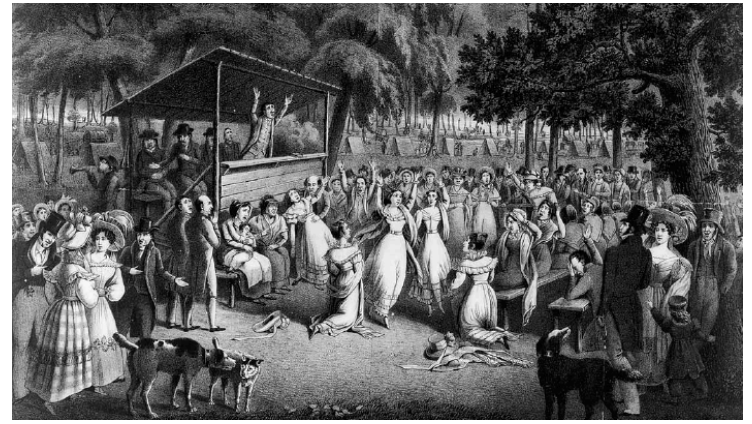
Figure 7. Meeting in the West by A. Rider 1830–1835. Ink drawing. Courtesy of the Library of Congress.